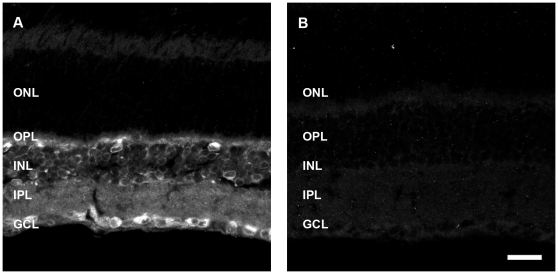
The antibody CT20 detects APP-immunoreactive protein in WT but not APP-KO retina.(A) Immunohistochemistry on a transverse retinal section from an adult WT mouse shows CT20 labels APP immunoreactivity in the outer plexiform layer (OPL), inner nuclear layer (INL), inner plexiform layer (IPL) and ganglion cell layer (GCL) but not in the outer nuclear layer (ONL). (B) The APP-KO retina does not label with the CT20 antibody, suggesting that the antibody is specific for APP in retinal sections. Scale, 20 microns.